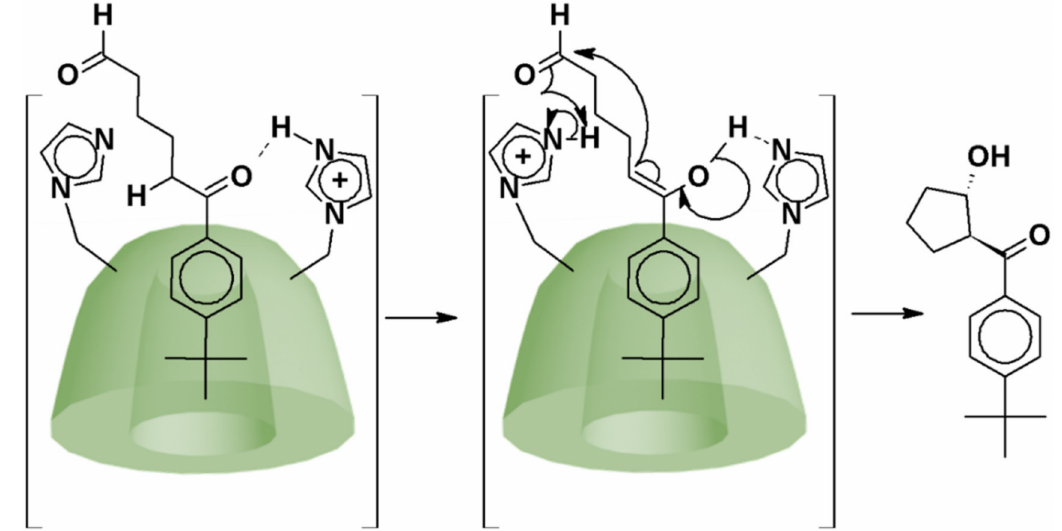
Figure 7. Intramolecular condensation of ketoaldehyde to aldol catalyzed by the bisimidazole- functionalized β -CD.